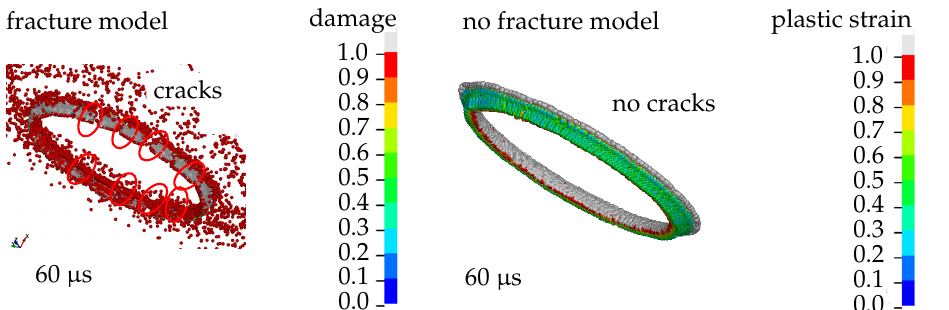
Figure 1. Cracks are visible only when the fracture model is enabled. Otherwise, the ring stays intact until the particles loose